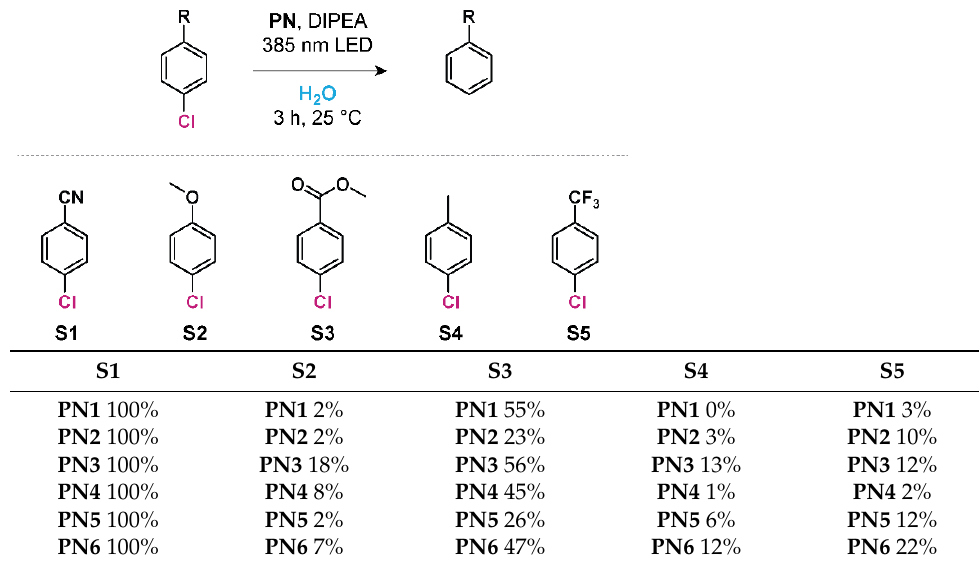
Table 1. Conversion of para -substituted chlorobenzenes to benzene derivatives using PN1 – 6 1 .